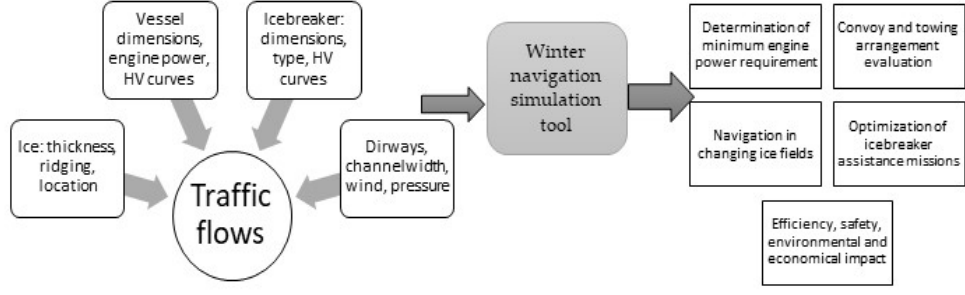
Figure 1. Block diagram of the simulation tool.